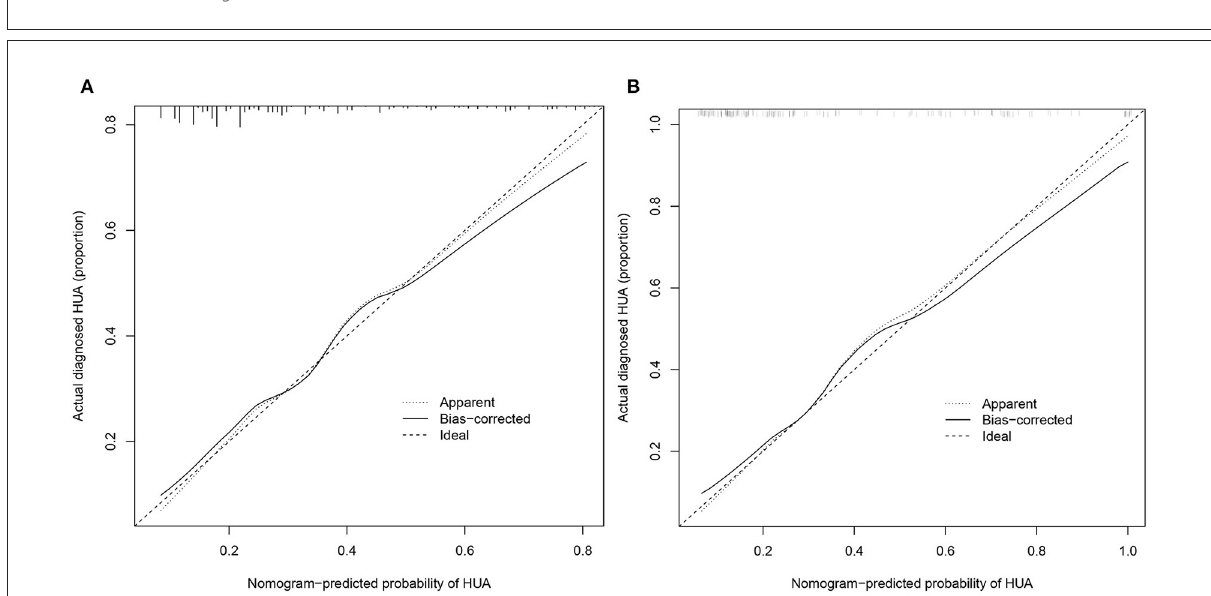
FIGURE5 Calibration curves . (A) Training cohort and (B) validation cohort. The x-axis represents the predicted HUA risk. The y-axis represents the actual diagnosed HUA. The diagonal dotted line represents a perfect prediction by an ideal model. The solid line represents the performance of the nomogram, of which a closer fit to the diagonal dotted line represents a better prediction.